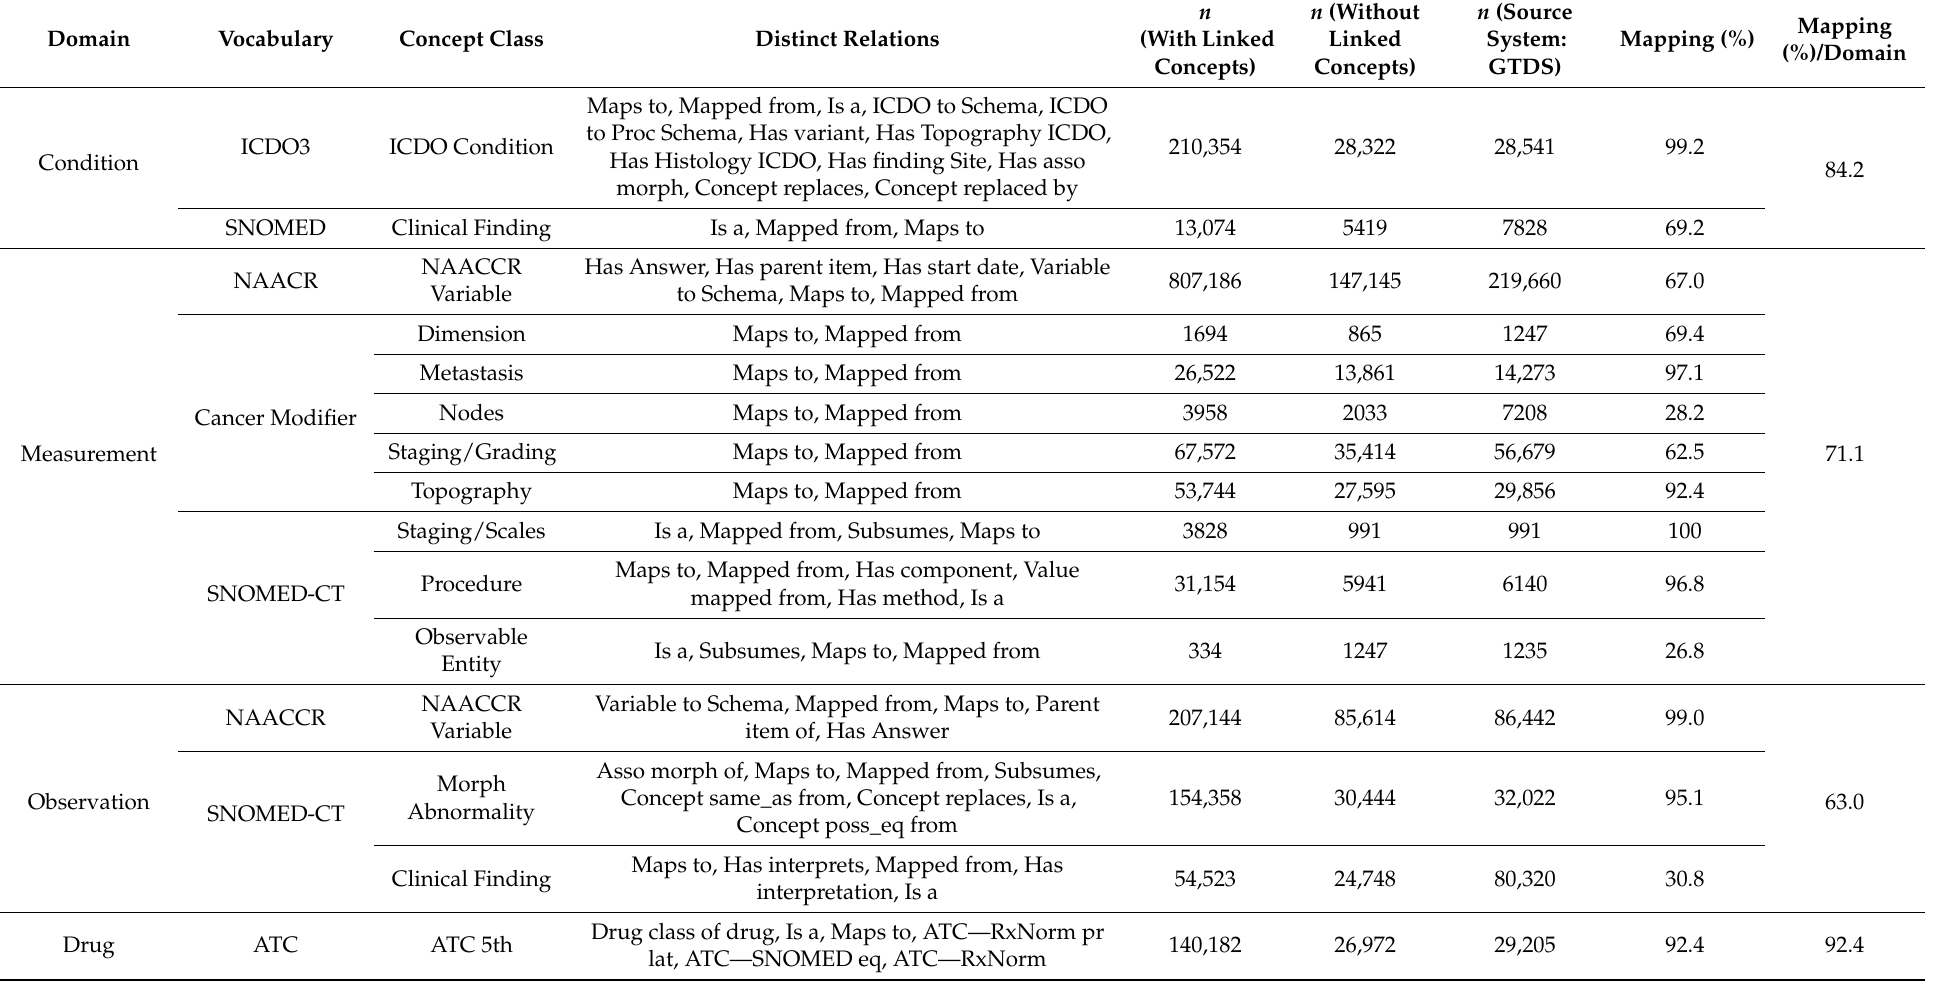
Table 3. Mapped Vocabulary by